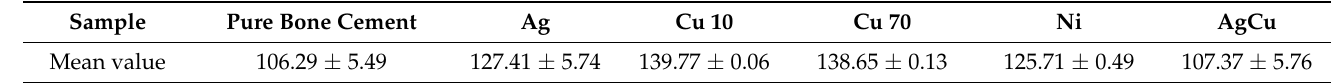
Table 4. Water contact angle values for bone cement, pure and with